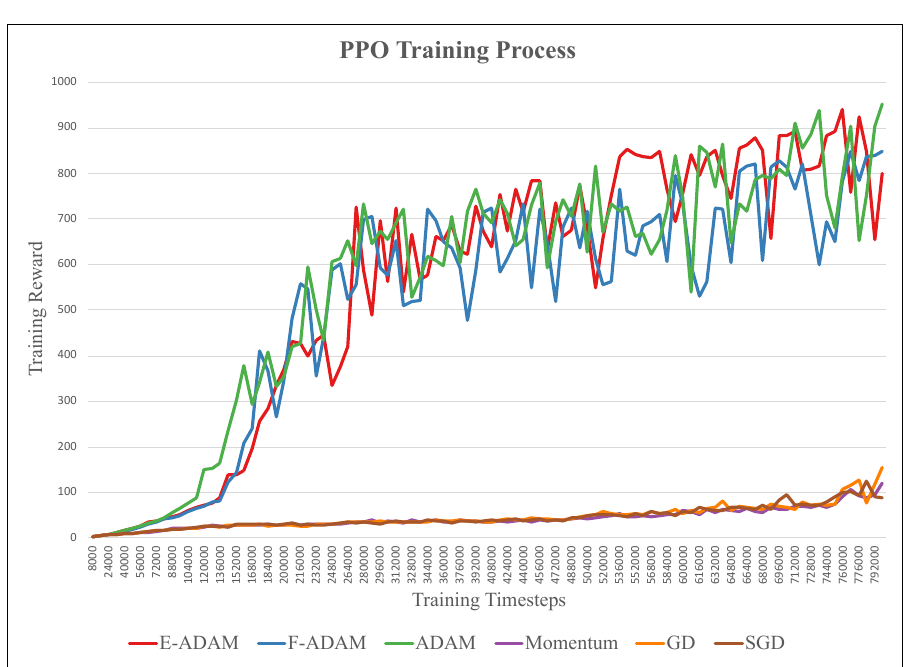
Figure 9. The overall training process of the